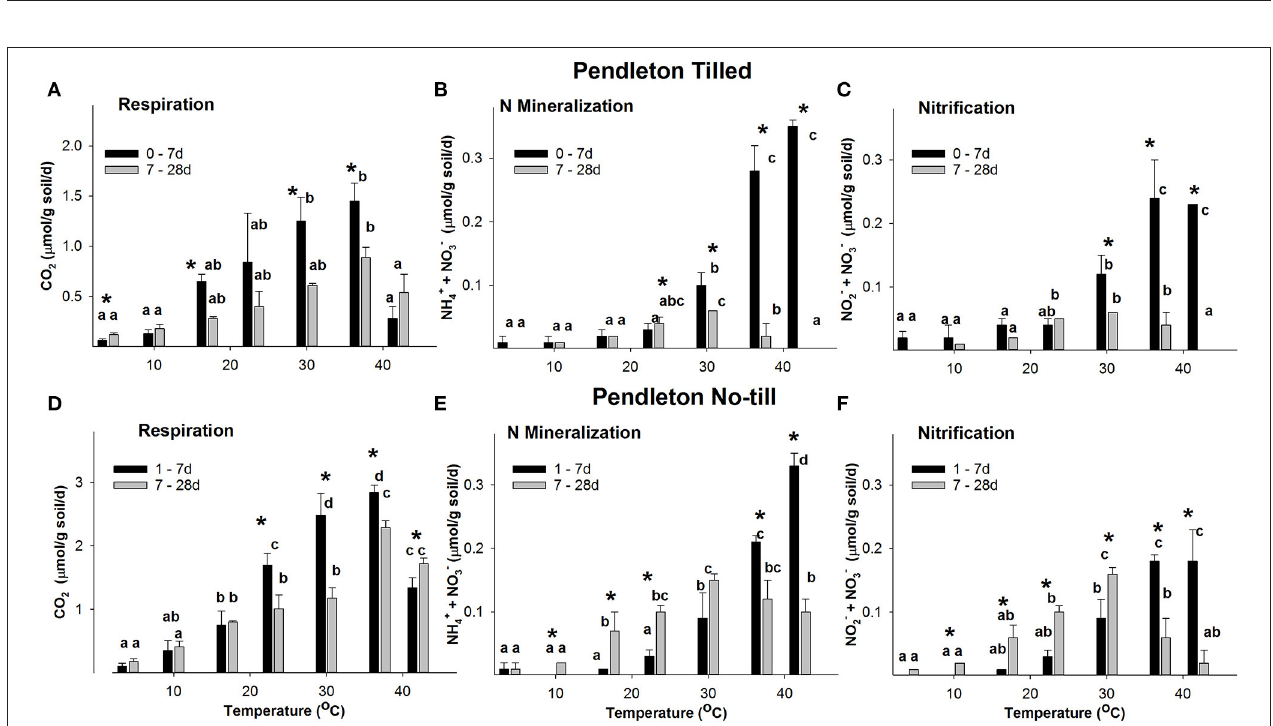
FIGURE 3 | The rate response of respiration (A,D) , N mineralization (B,E) , and nitrification (C,F) in Pendleton soils across temperatures. Figure data are the average of three field replicates and the error bars represent the standard deviation. Lower case letters indicate where RM ANOVA analysis found significant differences in rates over the temperatures within a time period. Asterisks indicate where rates at 0–7 d differ significantly from 7 to 28 d ( p ≤ 0.05).